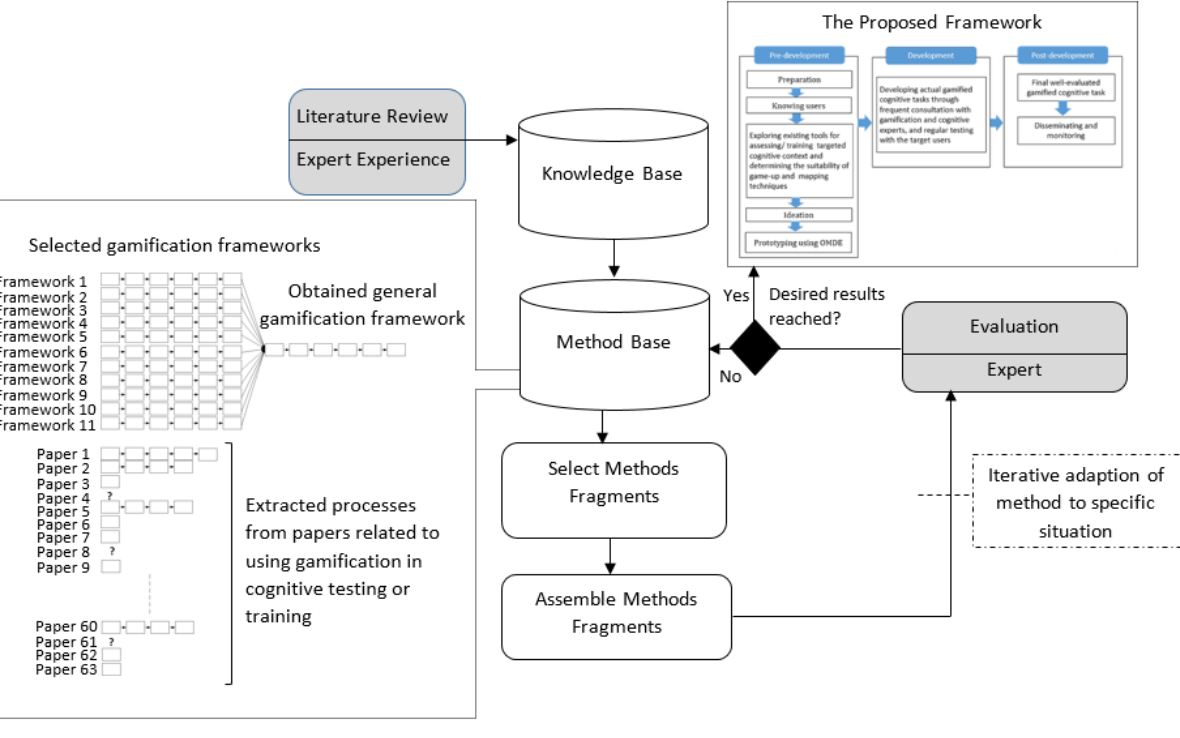
Figure 3. Situational method engineering approach followed for developing the framework (adapted from